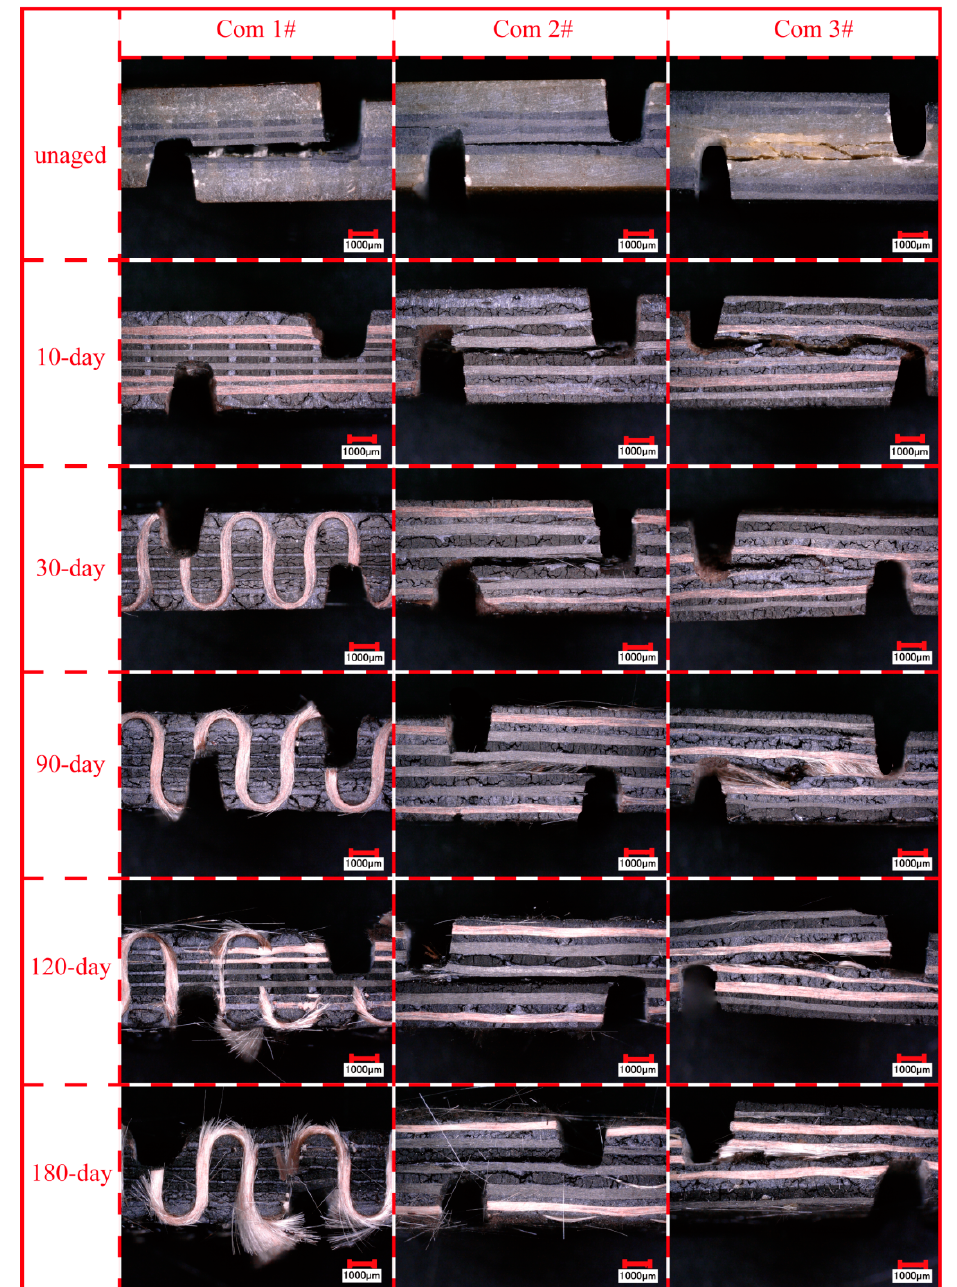
Figure 7. The fracture morphologies of unaged and aged inter-laminar shear specimens.